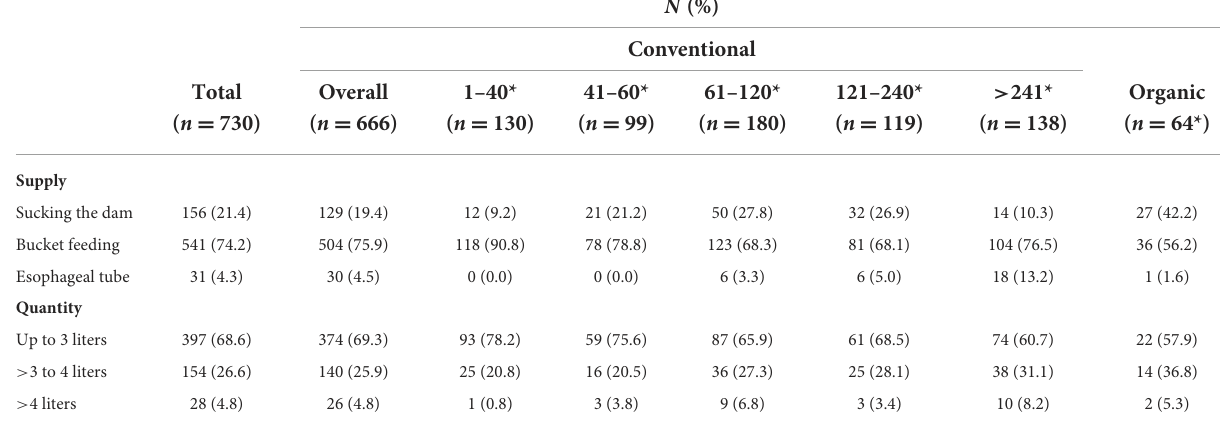
TABLE 3 Colostrum management in 730 dairy farms in Germany stratified by herd size and farm